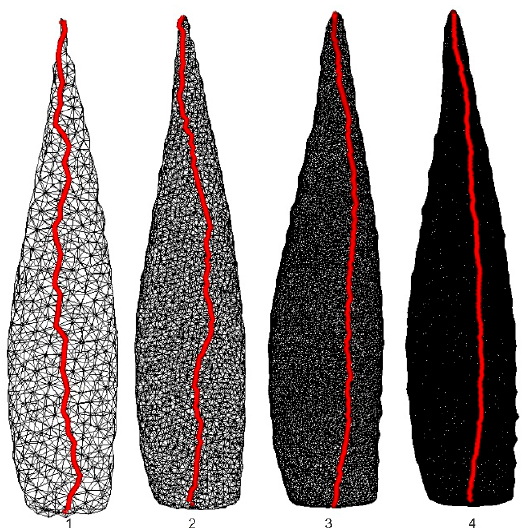
Figure 6. Fragments of the same object (an Aloe marlothii leaf) depicted as the triangular mesh with different resolutions and with the shortest distances between two points.